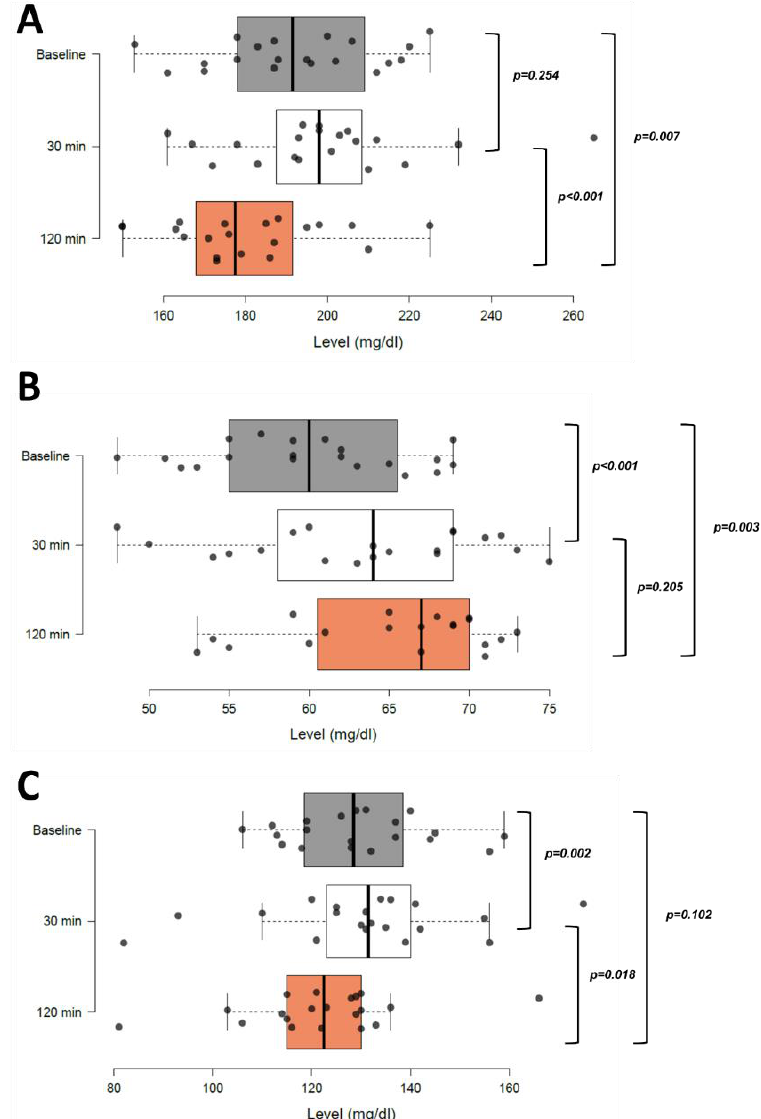
Figure 2. Changes in lipoprotein concentration after cannabis use. ( A ) Cholesterol concentration was significantly reduced 120 min after cannabis intake. ( B ) HDL-C cholesterol showed significant increases at 30 and 120 min of cannabis use. ( C ) LDL-C showed a significant increase 30 min after cannabis use followed by a decrease which was not significant relative to